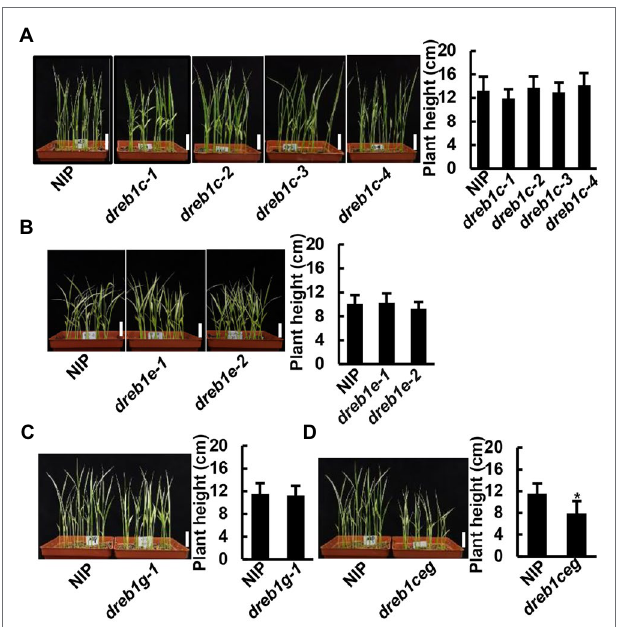
FIGURE 3 | The dreb1ceg mutant had reduced growth at seedling stage under suboptimal low temperature. Growth phenotypes and quantification of plant heights of dreb1c (A) , dreb1e (B) , dreb1g (C) and dreb1ceg (D) grown at 16 ° C for 32 days. Seeds were germinated at 28 ° C for 3 days, and then transferred to 16 ° C for 32 days. Shown is the mean value ±SD of 24 seedlings. Similar results were obtained from two additional biological repeats. Each replicate has 24 seedlings. Asterisks indicate significant differences compared to NIP (* p < 0.05, Student’s t -test). Bars in plant images represent 2 cm.